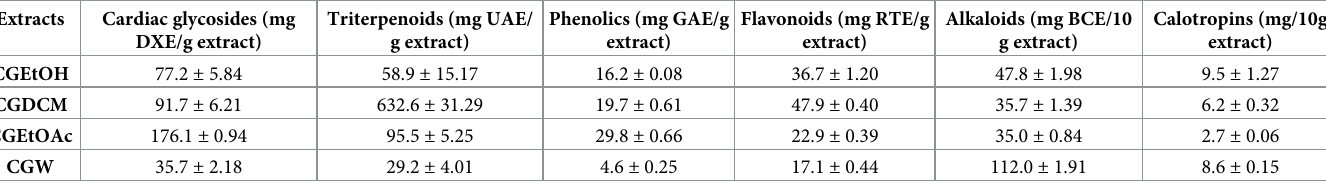
Table 1. Content of secondary metabolites and calotropin in the Calotropis gigantea stem bark extracts. Extracts Cardiac glycosides (mg DXE/g